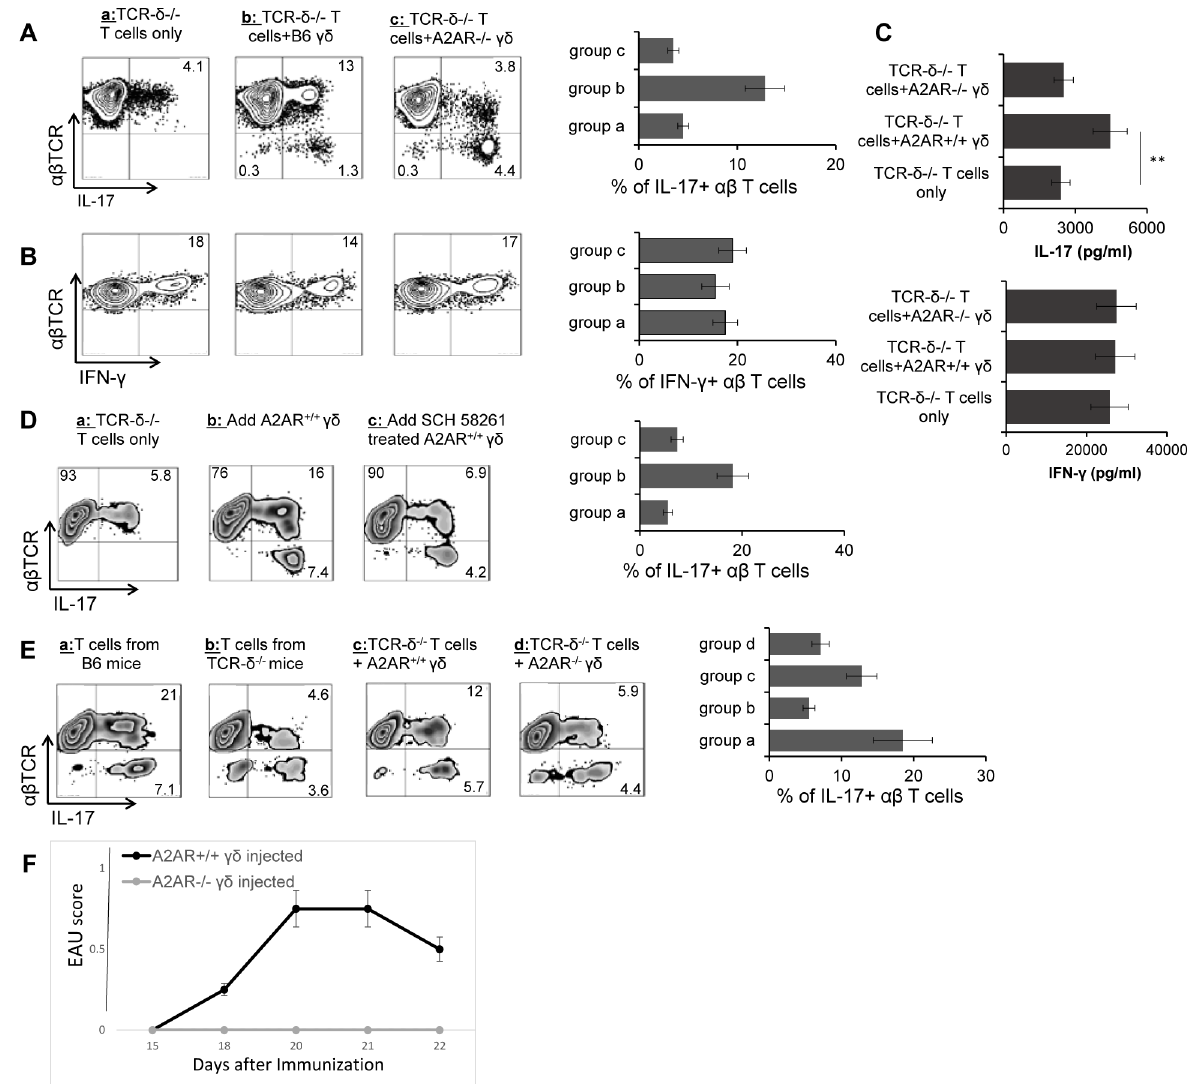
Fig 1. A2AR -/- γδ T cells have a limited enhancing effect on autoimmune responses. A &B) A2AR +/+ enhanced the Th17 response, but A2AR -/- γδ T cells did not; and neither enhanced the Th1 response. A2AR +/+ and A2AR -/- γδ T cells were isolated from immunized wt-B6 or A2AR -/- mice, respectively. Responder αβ T cells (1 x 10 6 /well) prepared from IRBP 1-20 immunized TCR- δ -/- mice on day 13 post-immunization were stimulated for 5 days with immunizing antigen and APCs under Th17 (A) of Th1 (B) polarized conditions with or without addition of 2% (2 x 10 4 /well) A2AR +/+ or A2AR -/- γδ T cells. The numbers of αβ TCR + IL-17 + and αβ TCR + IFN- γ + cells were calculated by FACS analysis after a 5-day in vitro stimulation. C) Addition of A2AR +/+ γδ T cells, but not of A2AR -/- γδ T cells, to αβ responder T cells enhanced IL-17 production but did not affect IFN- γ production. Production of IL-17 and IFN- γ by immunized TCR- δ -/- mice was assessed by ELISA, after in vitro stimulation with the immunizing peptide (IRBP 1-20 ), in the presence of A2AR +/+ or A2AR -/- γδ T cells (2%). Cytokine amounts were evaluated in the culture cell supernatants by ELISA after a 48 h stimulation. D) Treatment of A2AR antagonist abolished the enhancing effect of A2AR +/+ γδ T cells. A2AR +/+ γδ T cells were added to responder αβ T cells in culture, with or without a pre-incubation with SCH58261, a selective A2AR antagonist (100nM) [29,30].Results show that blockade of A2AR ligation abolished the enhancing effect of A2AR +/+ γδ T cells. E) Administration of TCR- δ -/- mice with A2AR +/+ γδ T cells, but not with A2AR -/- γδ T cells, enhanced the Th17 response. Groups (n = 4) of TCR- δ -/- mice were injected with A2AR +/+ or A2AR -/- (1 x 10 6 /mouse) γδ T cells, before they were immunized with a pathogenic dose of IRBP 1-20 /CFA. At 13 days post-immunization, the Th17 responses were assessed 5 days after in vitro stimulation. The results shown are representative of those from five experiments. Differences were considered significant when P (cid:20) 0.05 (asterisk) and very significant when P (cid:20) 0.01 (two asterisks). F.) TCR- δ -/- mice injected with A2AR +/+ , but not A2AR -/- , γδ T cells were more susceptible to induced EAU. Groups of TCR- δ -/- mice were immunized with IRBP 1-20 /CFA with or without a prior injection of 1 x 10 5 (per mouse) A2AR +/+ or A2AR -/- γδ T cells. EAU was scored as previously reported [3,4,8].The results of two separate experiments are